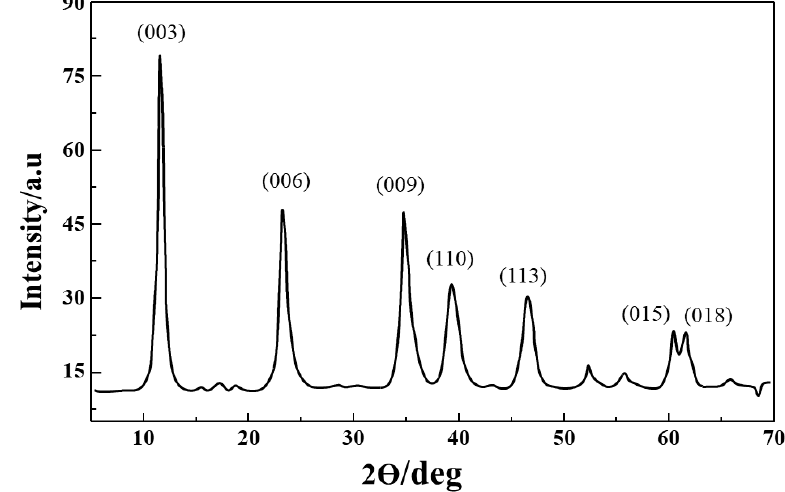
Figure 8. X-ray diffraction patterns of Mg/Al